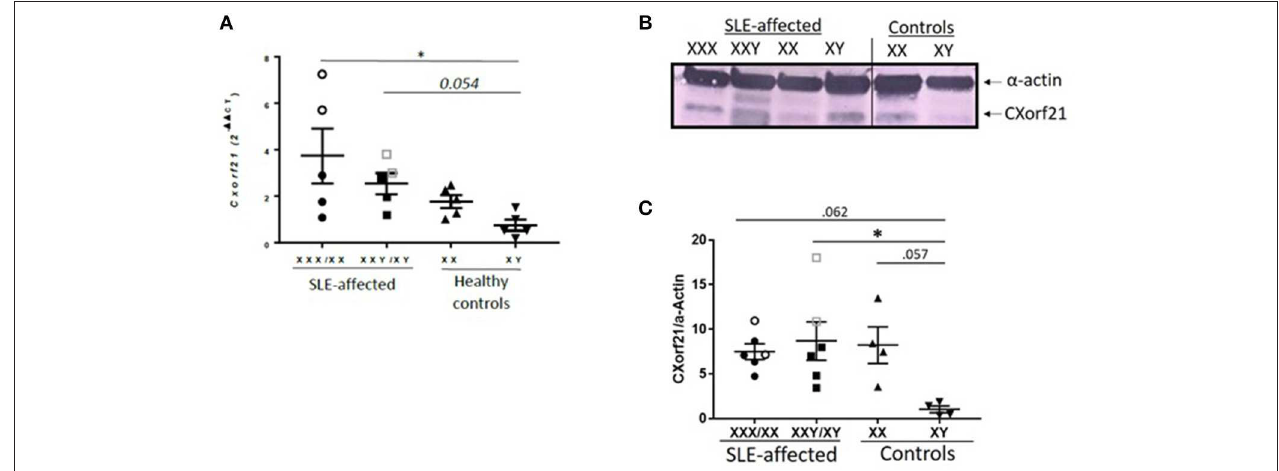
FIGURE 2 | CXorf21 is differentially expressed in primary immune cells of healthy controls and SLE-affected patients. (A) RT-qPCR of CXorf21 mRNA expression in LCLs from SLE-affected females ( n = 5) (47,XXX female patients are represented in clear circles), SLE-affected males ( n = 5) (47,XXY male patients are represented in clear squares), healthy females ( n = 5), and healthy males ( n = 5). One-way ANOVA Kruskal-Wallis nonparametric test with a Dunn’s multiple comparisons * p < 0.05; Error bars represent SEM. (B) Total protein extract was harvested from SLE-affected and unaffected male and female LCLs were subjected to SDS-PAGE. Western blotting using human anti-CXorf21 antibody (34 kD) identifying bands at the appropriate molecular weight. Human anti-alpha actin (42 kD) is shown as a loading control. (l-r) Lane 1: 47,XXX female lupus patient, lane 2: 47,XXY male lupus patient, lane 3: 46,XX female lupus patient, lane 4: 46,XY male lupus patient, lane 5: 46,XX female control patient, lane 6: 46,XY male control patient. This blot is representative of 4 different experiments and the order was rearranged to correlate with mRNA graph in this figure. (C) Quantitative protein analysis of CXorf21/Actin was determined for all blots using GelAnalyzer (47,XXX and 47,XXY patients are represented in clear circles and squares). A nonparametric ANOVA was performed using to determine statistical significance. ( Figure 3A ). We isolated primary classical CD14 ++ /CD16